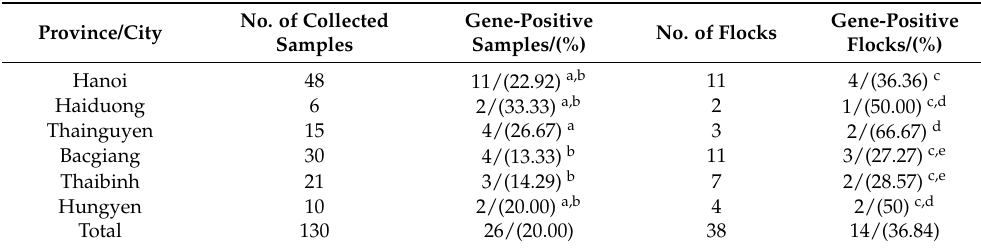
Table 3. Detection of waterfowl parvovirus genome in field duck samples obtained from different northern provinces/cities of Vietnam.